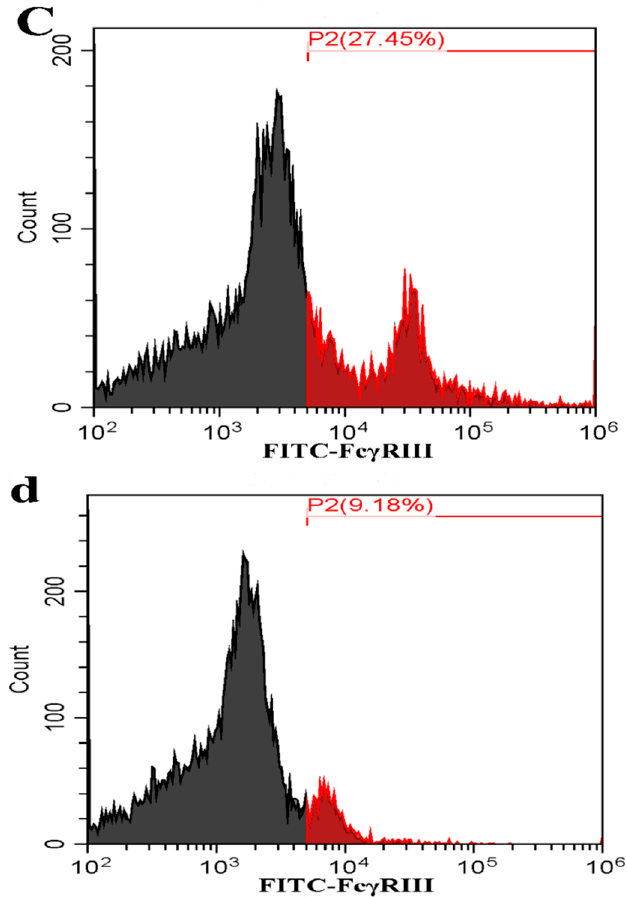
Figure 4. The cytomembrane protein level of Fc γ RI or Fc γ RIII on PAMs. PAMs cells were transfected with porcine Fc γ RI or Fc γ RIII siRNA for forty-eight hours and then used for the analysis of flow cytometry. ( a ) The cytomembrane protein level of Fc γ RI on the PAMs cells following negative control siRNA transfection; ( b ) The cytomembrane protein level of Fc γ RI on the PAMs cells following porcine Fc γ RI siRNA transfection; ( c ) The cytomembrane protein level of Fc γ RIII on the PAMs cells following negative control siRNA transfection; ( d ) The cytomembrane protein level of Fc γ RIII on the PAMs cells following porcine Fc γ RIII siRNA transfection.